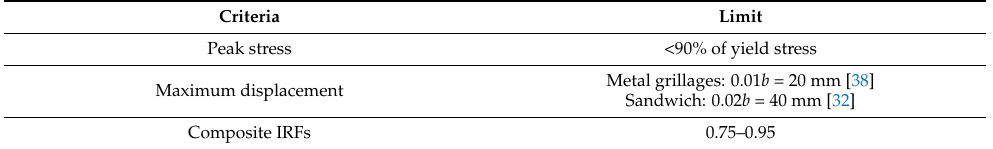
Table 6. Criteria for successful candidates. ( b is taken as the panel span of the region of